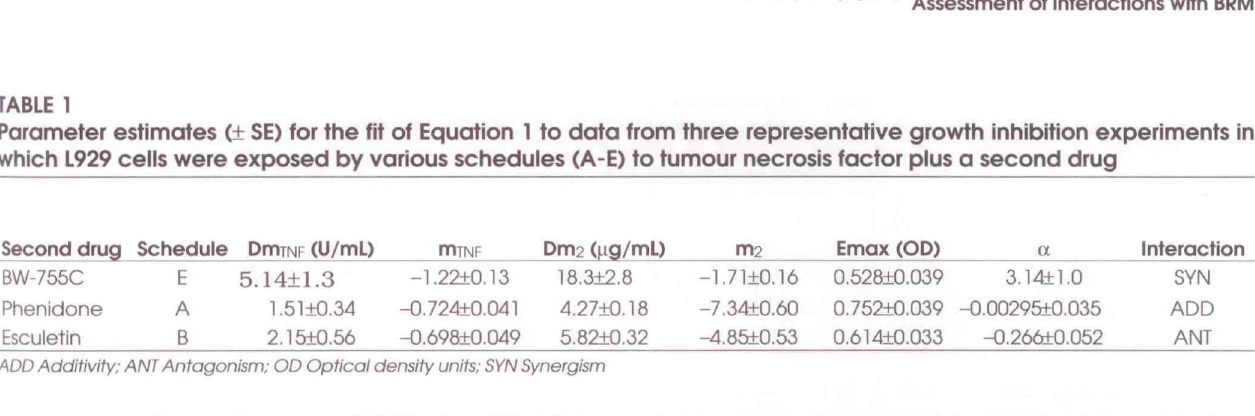
Table 1. Note that most of the standard errors are from